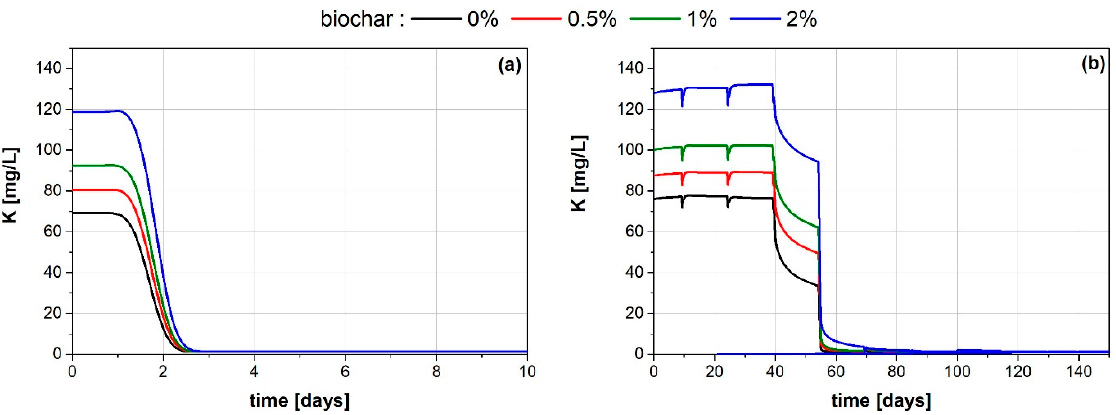
Figure 4. Potassium release under ( a ) saturated flow conditions and ( b ) unsaturated flow conditions, for the E.E. approach and different soil/biochar mixtures.